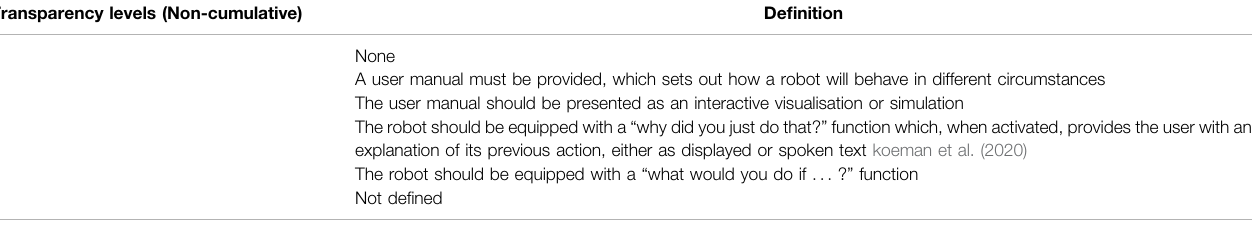
TABLE 1 | Transparency levels for end users. Transparency levels (Non-cumulative)